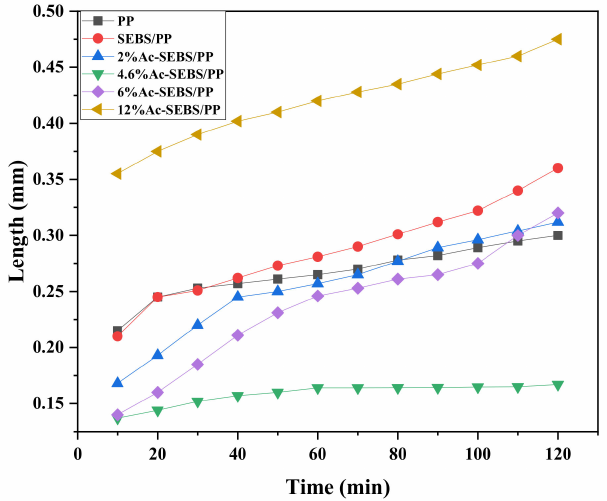
Figure 8. Relationship between the tree length and the treeing